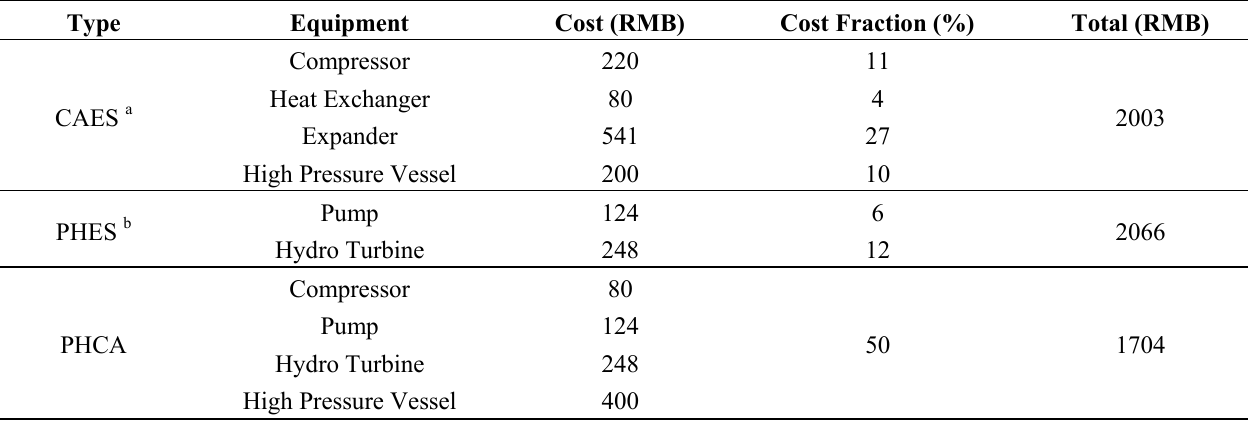
Table 2. Main equipment cost comparison of 1 MW energy storage